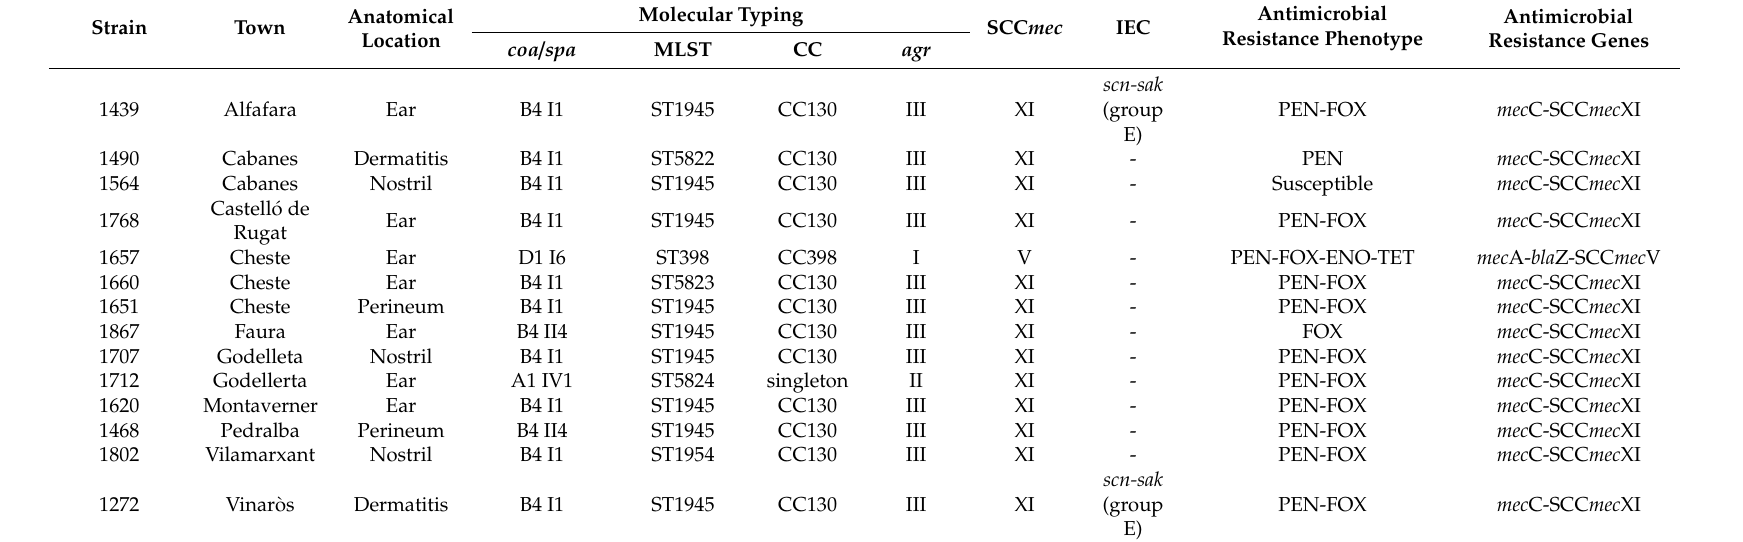
Table 6. Characteristics of the MRSA isolates recovered in the di ff erent studied high-density